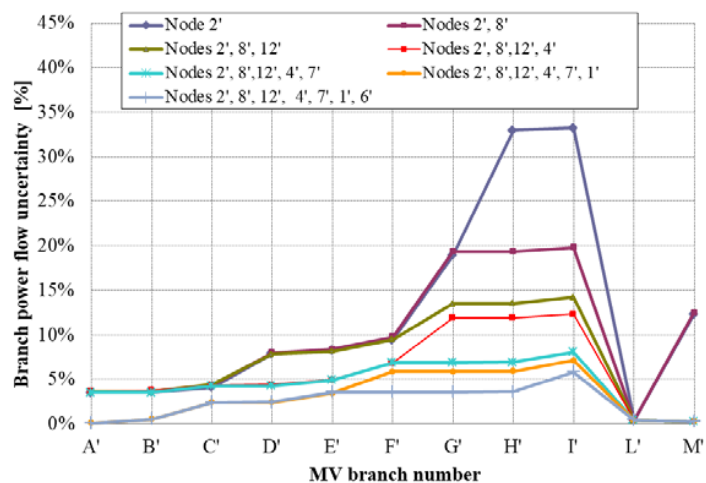
Figure 6 . Branch power flow uncertainties (referring to the total power of the AUSL feeder) obtained when the number and position of PMs are changed.